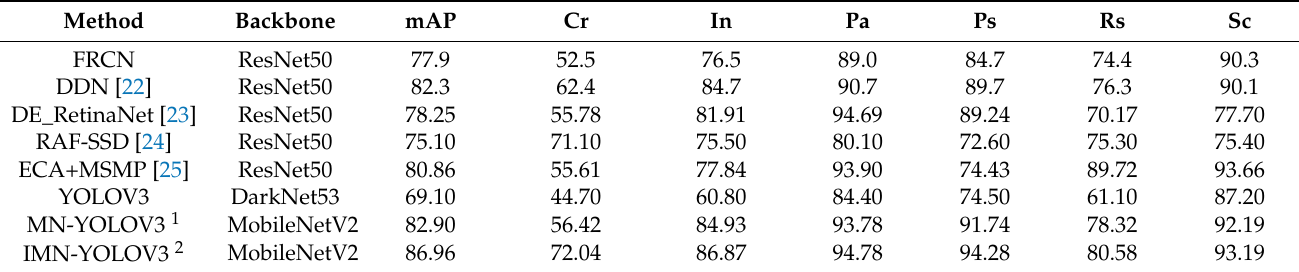
Table 4. Detection results on NEU-DET.